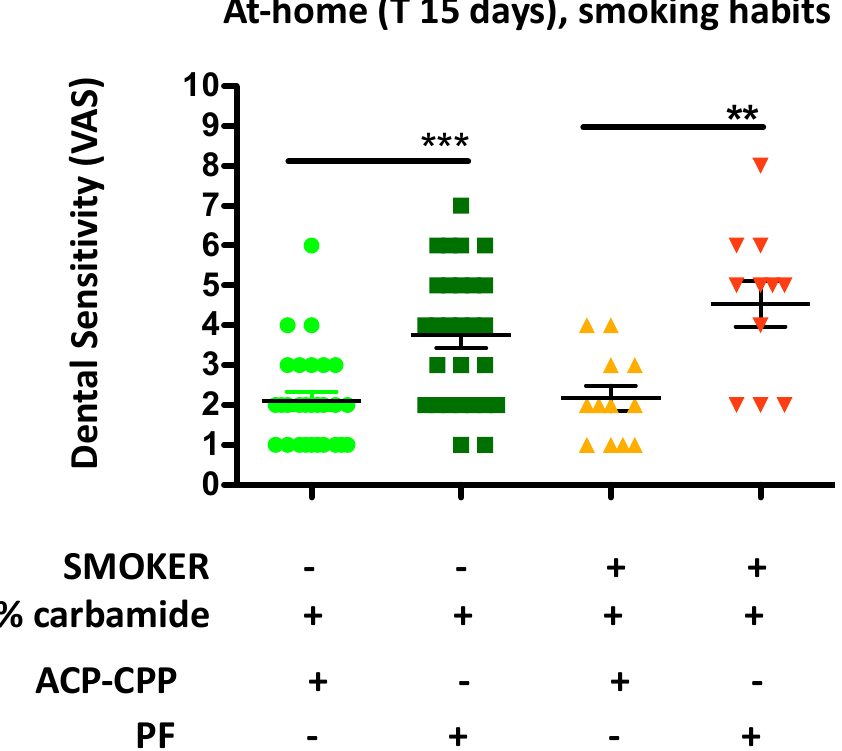
Figure 3. Effects of ACP-CPP administration on dental sensitivity, following at-home oral hygiene procedures as related to smoking habits. ACP-CPP treatment resulted in decreased dental sensitivity, as compared with the control (PF) group, both in non-smoker and smoker patients. Results are showed as mean ± SEM, ** p ≤ 0.01; *** p ≤ 0.0001 .